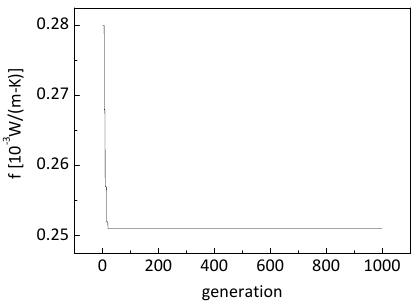
Figure 9. Evolution of the objective function.